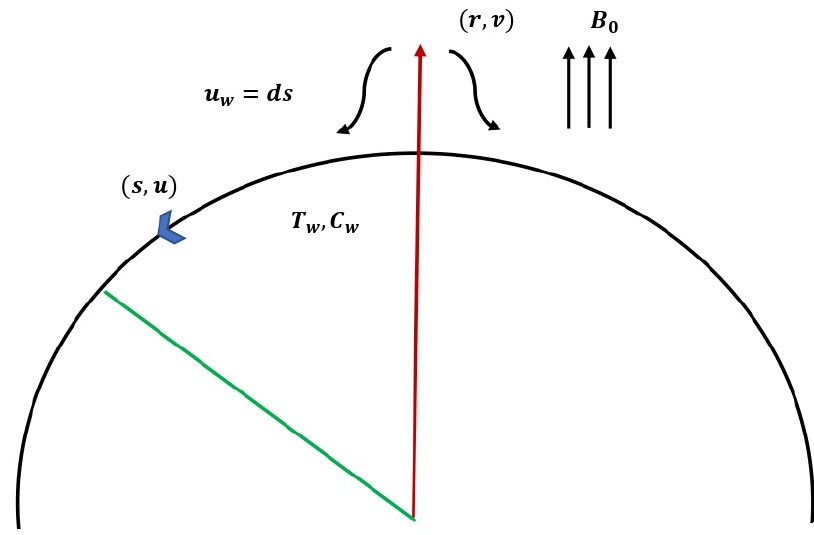
Figure 1. Flow design of the present study.